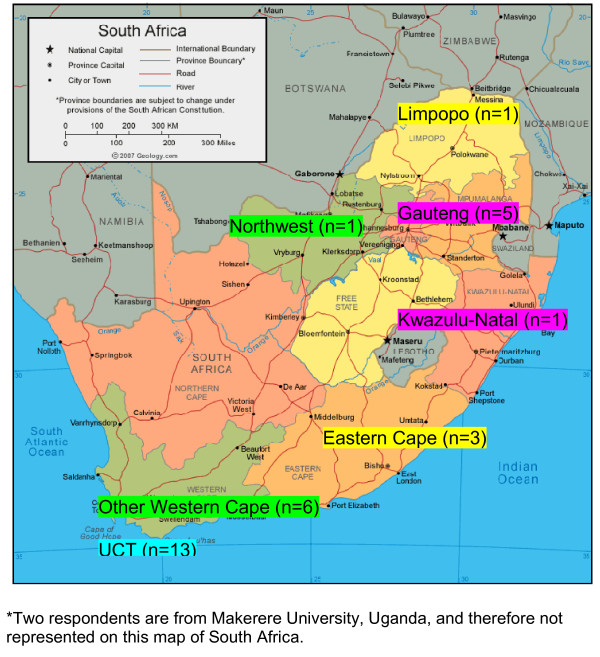
Provincial representation of academic health sciences institution affiliations of respondents*.